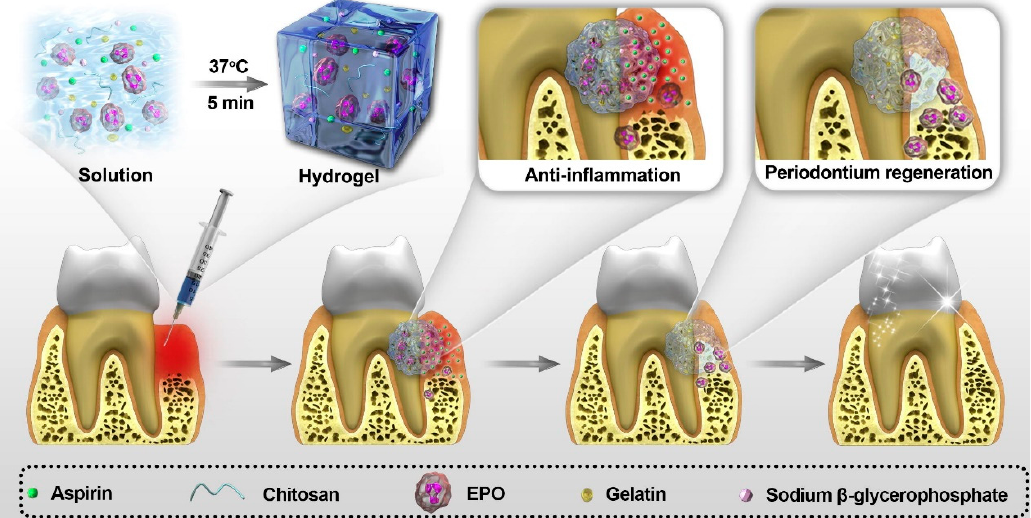
Figure 6. The application of hydrogel complex in periodontal treatment (Figure 6 is adapted from reference [80]